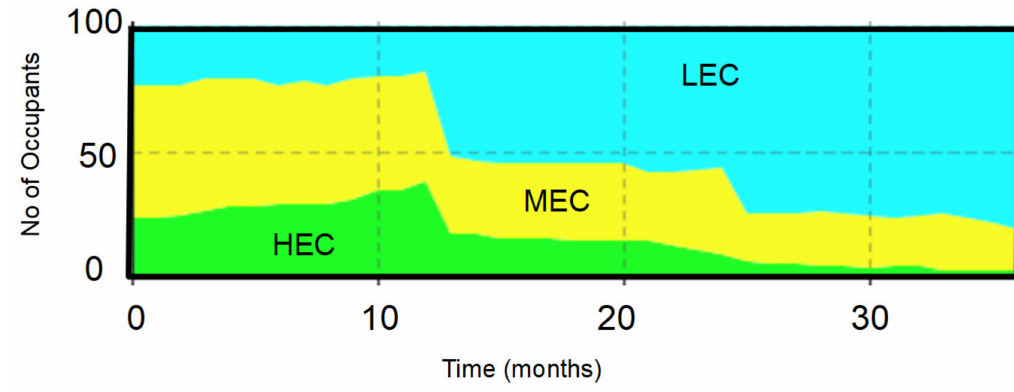
Figure 5. The density of the occupants in each category over time.